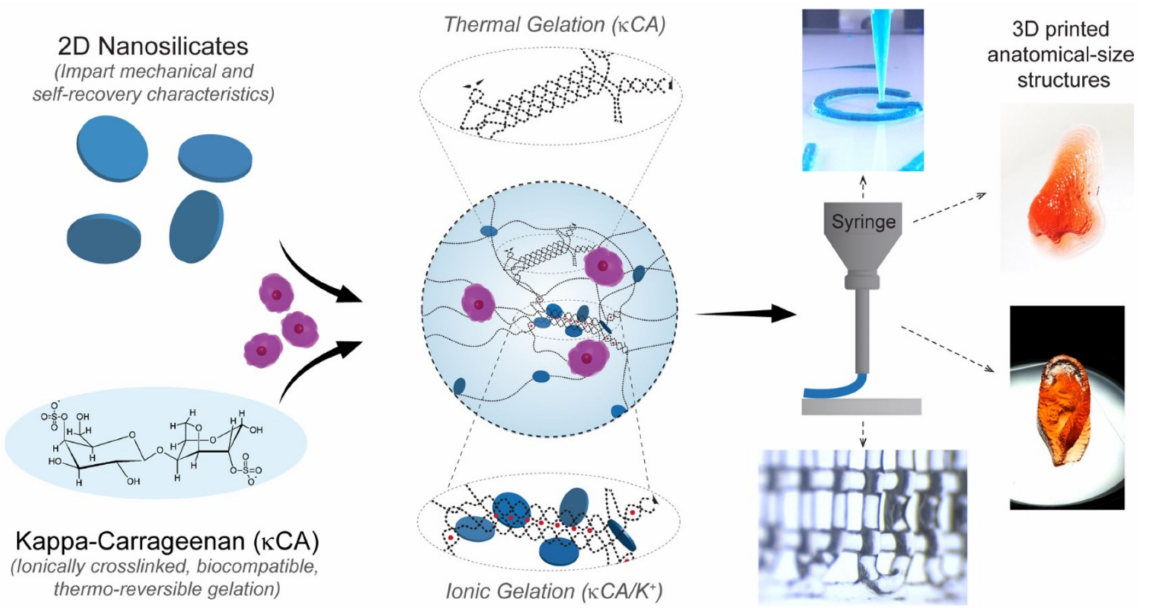
Figure 15. Interactions between LAP and k-CA polymer in a BI. Schematic representation of the crosslinking process of the thermoresponsiveness and ionic gelation. Adapted with permission from [113], American Chemical Society,